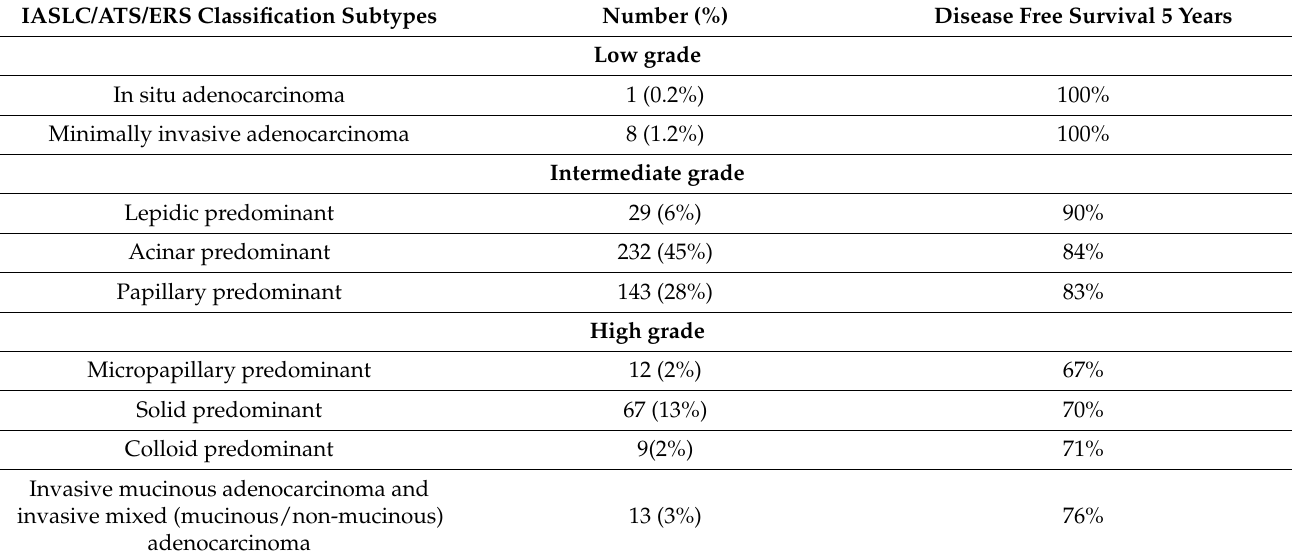
Table 2. Disease-free survival at 5 years, according to IASLC/ATS/ERS adenocarcinoma histological subtypes (adapted from